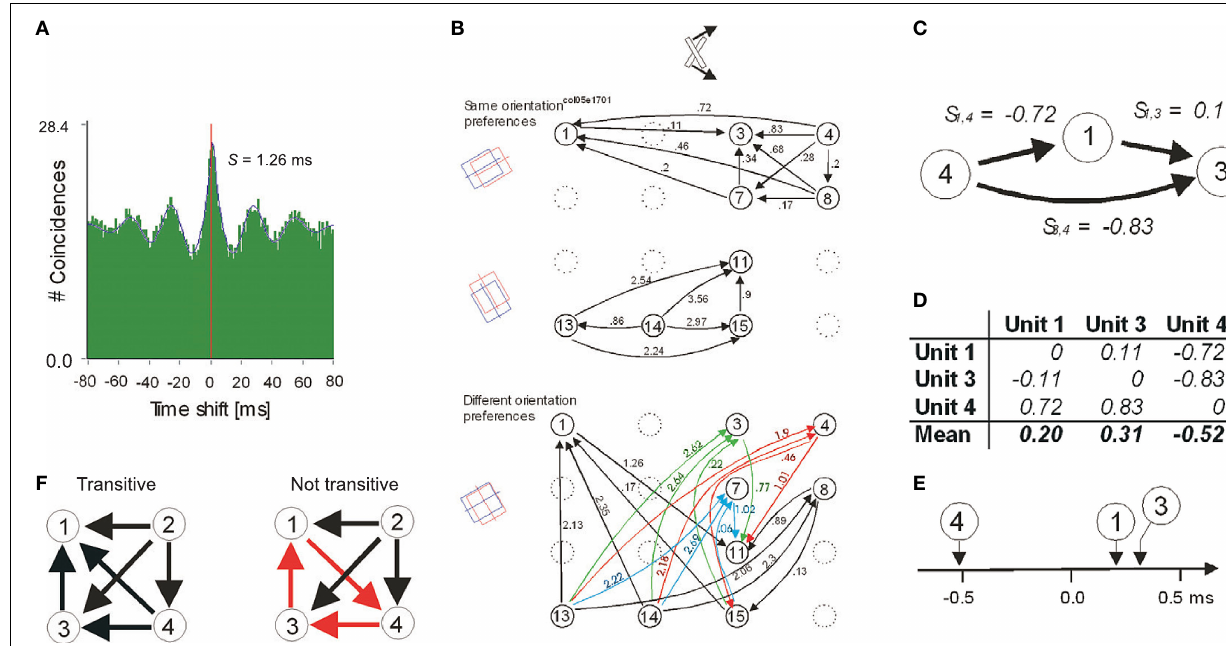
FIGURE 2 | Detection and comparison of neuronal fi ring sequences and the relationship between psychophysical measurements and strength of synchrony. (A) An example cross-correlogram (CCH) that indicates a shifted centre peak. The magnitude of shift is estimated by fi tting a Gabor function. (B) An apparently complex network of the directions (arrows) and the magnitudes of phase offsets (in milliseconds) extracted from all possible pair-wise CCHs as in (A) . The arrangements of the units within the 4 × 4 matrices refl ect the spatial positions of the recording sites on the 16-channel recording probes. The delays are segregated into two panels because otherwise the representation would be